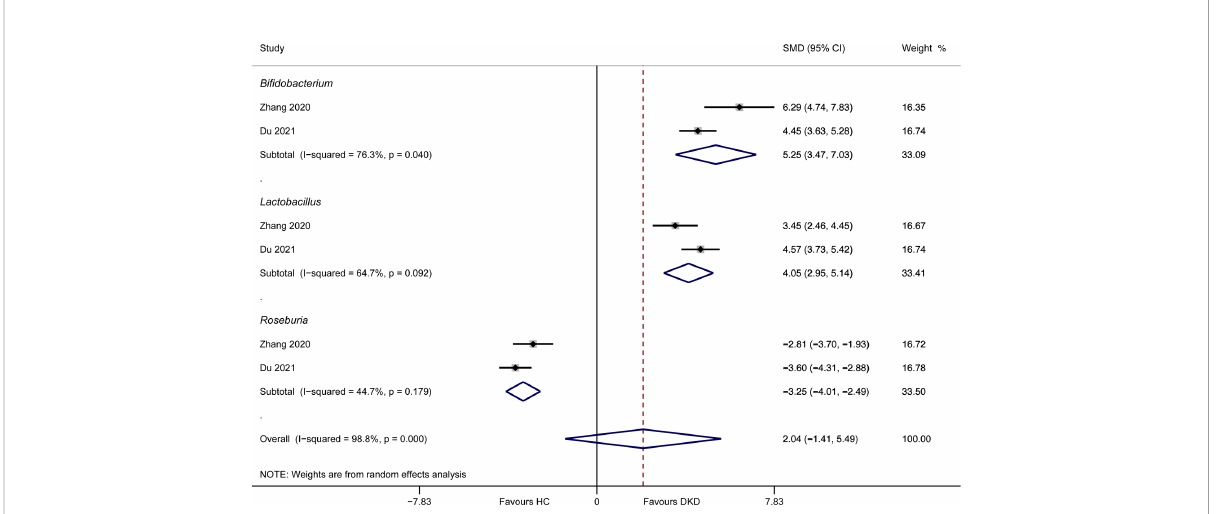
FIGURE 4 Meta-analysis of the genera between DKD and HC. DKD, diabetic kidney disease; HC, healthy controls; SMD, standardized mean difference; CI, con fi dence interval.